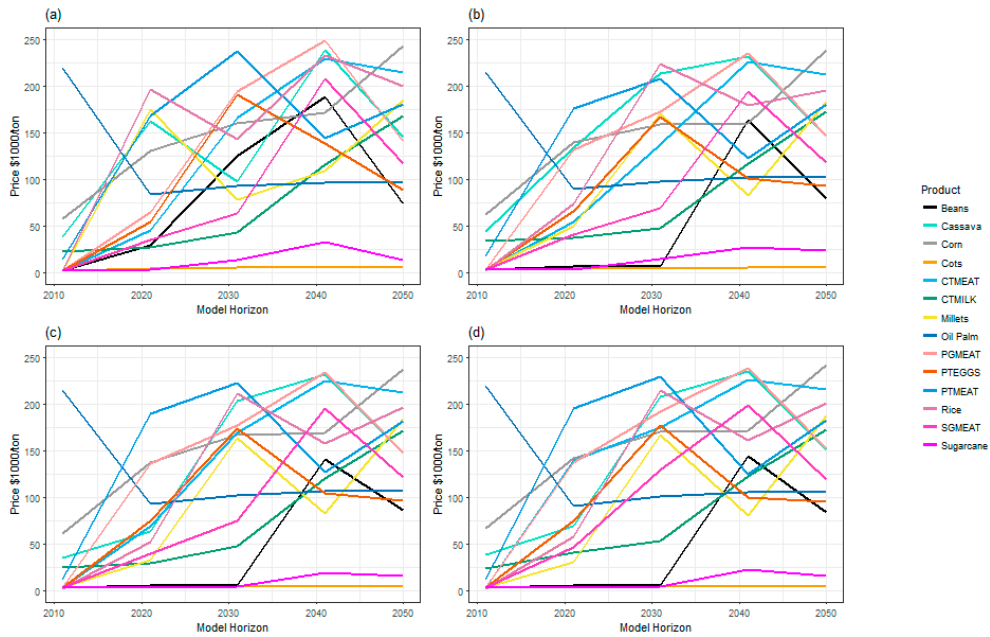
Figure 17. Agricultural product prices: ( a ) Baseline; ( b ) $40 carbon tax; ( c ) $80 carbon tax; ( d ) $120 carbon tax, under no subsidy action.